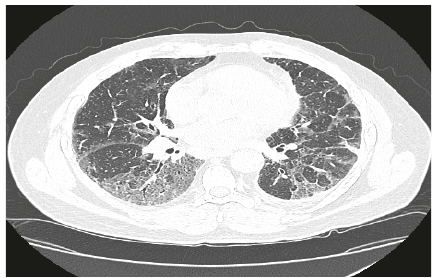
Figure 1: CT-high resolution chest without contrast. Taken 15 months before acute exacerbation. Ground glass opacities with thickening of the interlobular septa, predominantly in the lung bases.